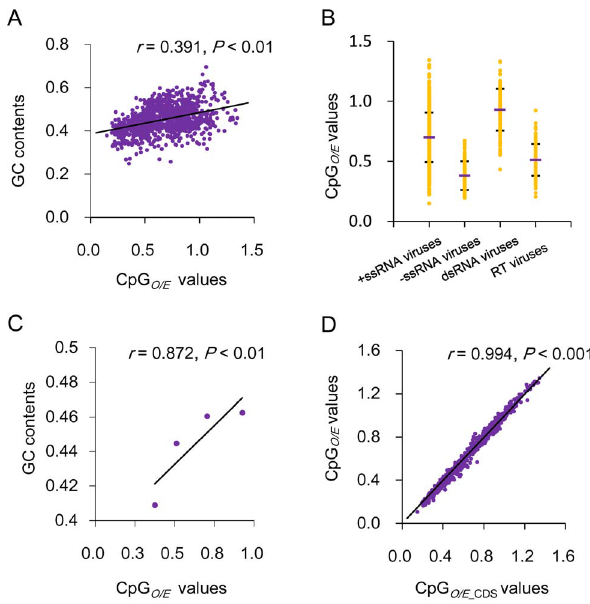
Figure 2. The influence of GC content on viral CpG usage. ( A ) Correlation between CpG odds ratios and GC contents of RNA viruses. (B) CpG usage variation between the four groups of RNA viruses. CpG O/E distribution range of each viral group is shown by yellow dots, and the mean CpG O/E value of each viral group is indicated by the purple bar. The standard deviations of the mean CpG O/E values are also indicated. ( C ) Correlation between the mean CpG O/E and mean GC content values. ( D ) Correlation between the CpG O/E and CpG O/E _CDS values.